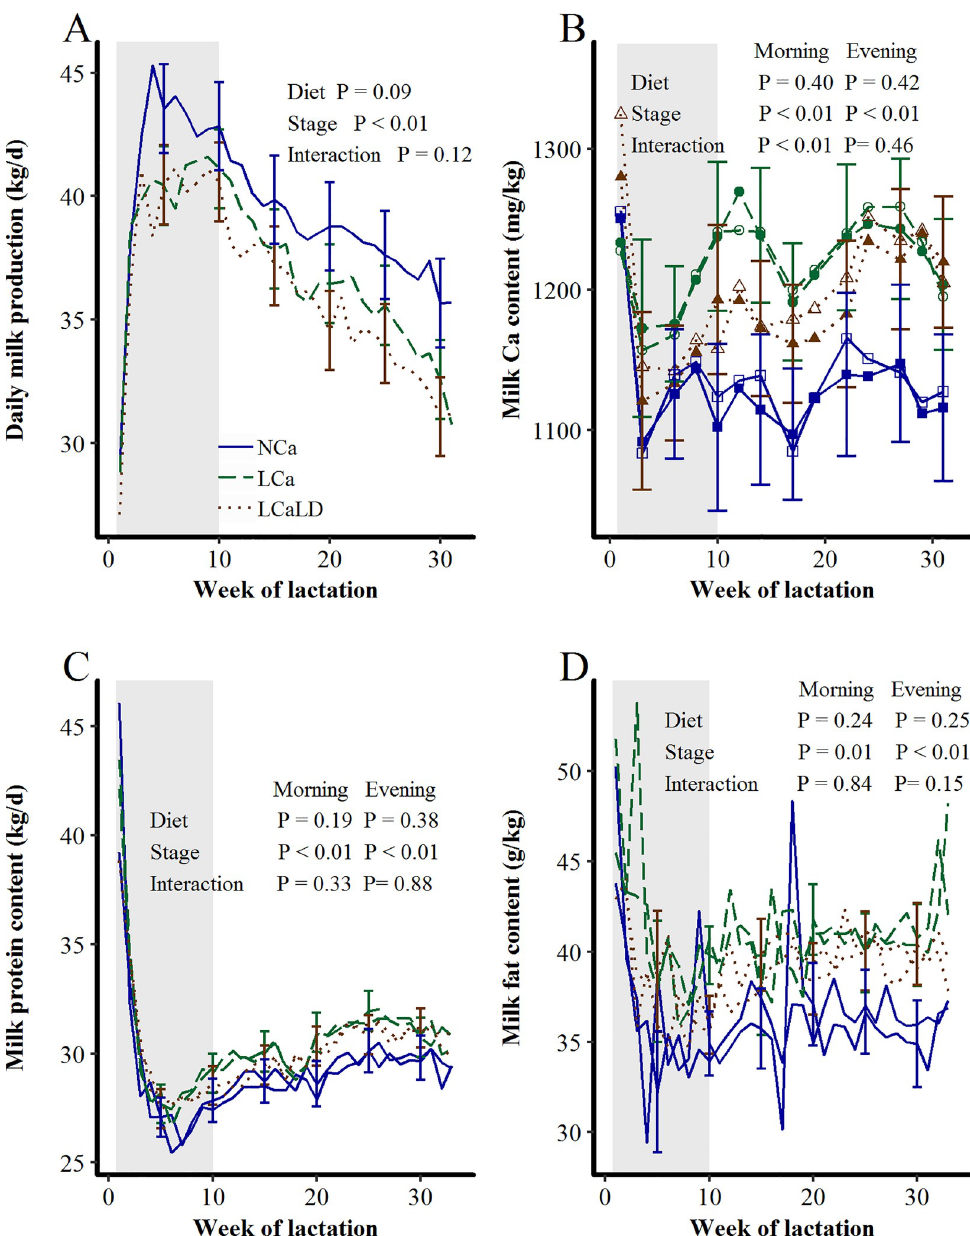
Fig 5. Effect of transient variation in dietary Ca content and the DCAD on A) daily milk production, B) milk Ca content, C) milk protein content and D) milk fat content between calving and 32 weeks of lactation. For figure B, color-filled shapes = morning milk Ca content, and white-filled shapes = evening milk Ca content. Treatments: NCa = normal Ca (4 cows), LCa = low Ca (5 cows), LCaLD = low Ca and low DCAD (5 cows). Gray background specifies the period during which cows were fed differentiated diets according to the treatments. Data were analyzed using a generalized linear mixed model with repeated values using PROC GLIMMIX in SAS [35]. Covariance matrix: SP for milk production and morning milk protein content and FA for morning and evening milk Ca contents, evening milk protein content and morning and evening milk fat contents. Vertical bars represent standard errors of the mean. Standard errors are shown every 5 weeks and in the morning for milk production, milk protein and fat contents for readability. The standard error for milk Ca content is shown every 2 weeks in the morning for readability.